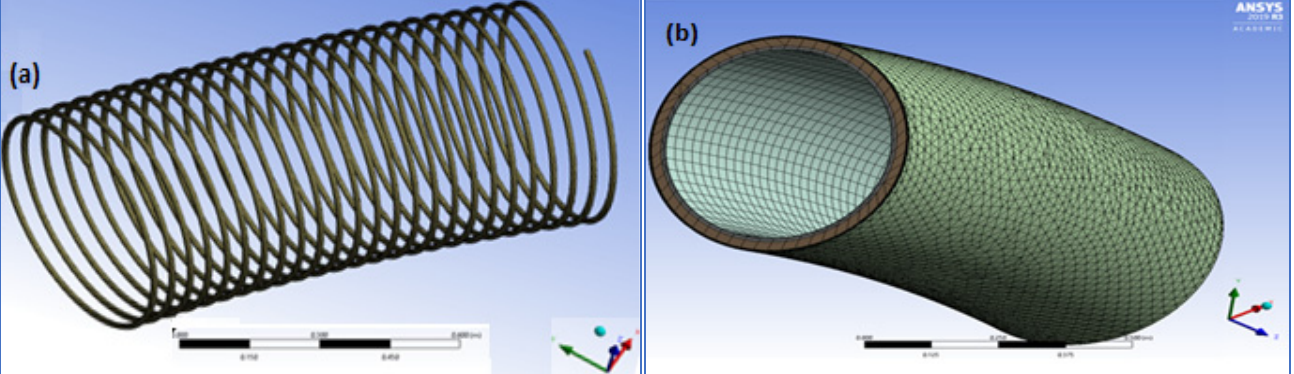
Figure 4. Mesh model of the ( a ) helix reinforcement and ( b ) simplified marine hose model.